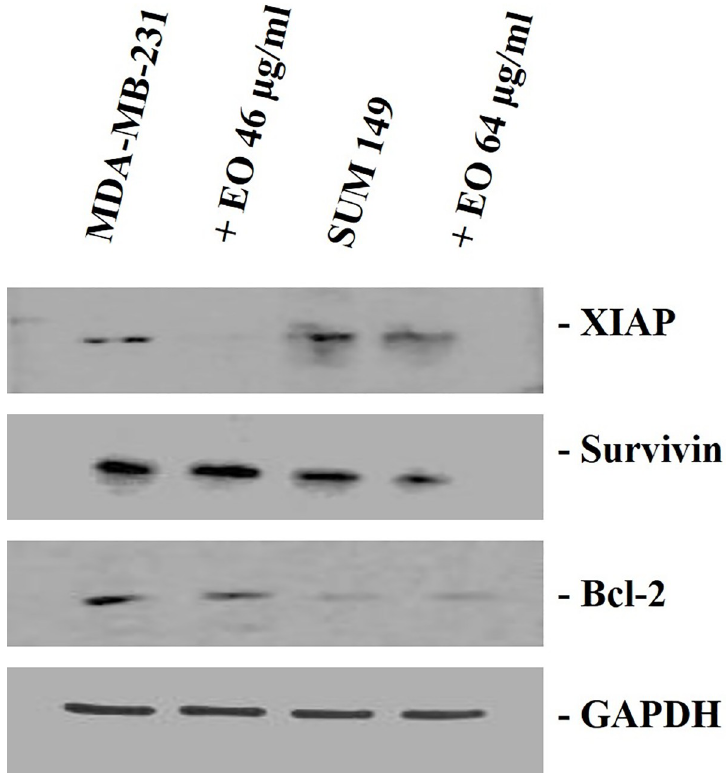
Fig 5. Western blotting analysis in MDA-MB-231 cells and SUM 149 cells. The cells were treated for 24 h with C . juttae essential oil (EO) (46 and 64 μ g/ml, respectively). The data shown are the results of a representative